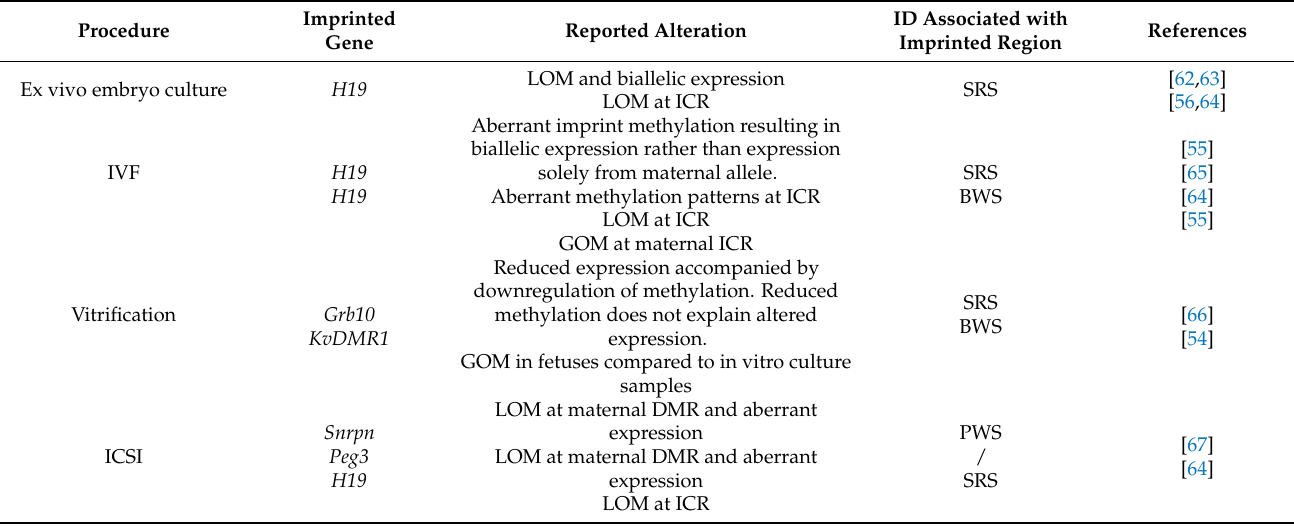
Table 1. DNA methylation and expression alterations of the imprinted genes implicated in IDs after ART procedures in mice.